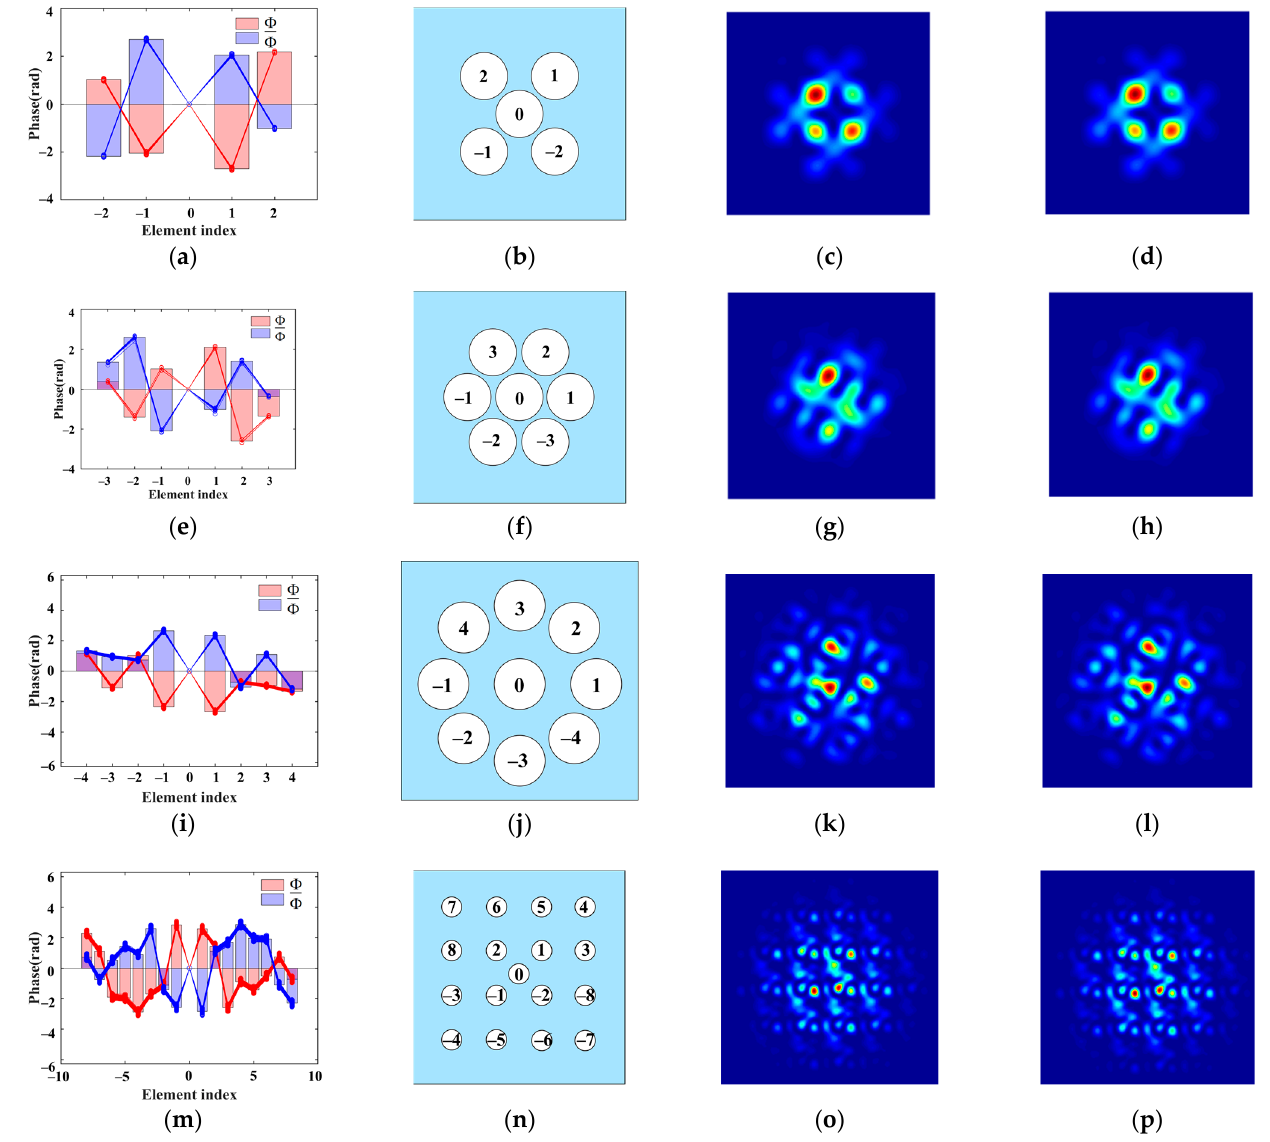
Figure 6. ( a ) Solutions which generate the samiliar far field as Φ in a 5-element system; ( b ) Emissive plane and element index in a 5-element system; ( c ) Far-field generated by Φ in a 5-element system; ( d ) Far-field generated by Φ in a 5-element system; ( e ) Solutions which generate the samiliar far field as Φ in a 7-element system; ( f ) Emissive plane and element index in a 7-element system; ( g ) Far-field generated by Φ in a 7-element system; ( h ) Far-field generated by Φ in a 7-element system; ( i ) Solutions which generate the samiliar far field as Φ in a 9-element system; ( j ) Emissive plane and element index in a 9-element system; ( k ) Far-field generated by Φ in a 9-element system; ( l ) Far-field generated by Φ in a 9-element system; ( m ) Solutions which generate the samiliar far field as Φ in a 17-element system; ( n ) Emissive plane and element index in a 17-element system; ( o ) Far-field generated by Φ in a 17-element system; ( p ) Far-field generated by Φ in a 17-element system. Aiming at verifying whether our method can effectively solve the phase ambiguity problem, we designed a simulation process similar to the previous one. The difference is that we not only require Θ and Φ to generate similar far-field images, but also the modulated ones to generate similar far-field images. The process is shown in Figure